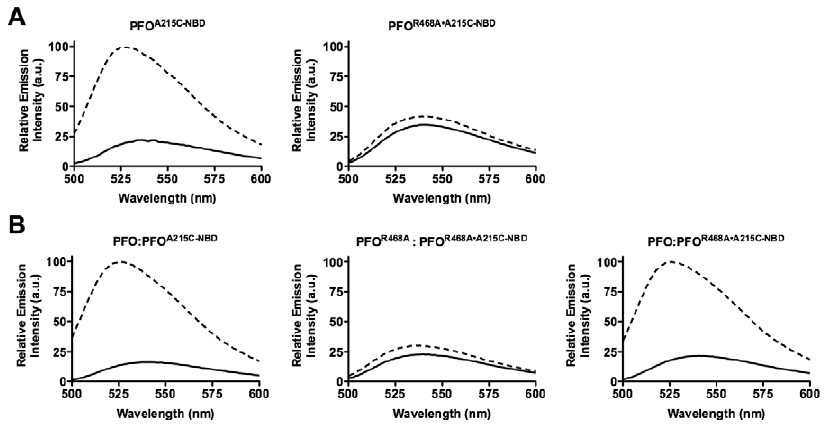
Figure 6. TMH insertion in PFO and PFO R468A . A cysteine was substituted for Ala-215 in PFO and PFO R468A , which is located in TMH1.The sidechain of Ala-215 is in an aqueous environment in the soluble monomer, but enters the membrane upon formation of the membrane spanning b - barrel [27]. Therefore an NBD probe positioned at this site undergoes a polar to nonpolar transition that is detected by an increase in the fluorescence emission of the probe.(A) Each NBD-labeled derivative was incubated in the presence (dashed line) and absence (solid line) of human erythrocyte ghost membranes. (B) Unlabeled native PFO or PFO R468A were mixed in a 4:1 molar ratio with PFO A215C-NBD and PFO R468A N A215C-NBD derivatives. The fluorescence emission for all experiments wasrelative to the maximum emission change observed for NBD-labeled PFO. The fluorescence emission intensity of NBD was measured from 500–600 nm. The data are representative of 3 experiments. doi:10.1371/journal.ppat.1002787.g006 quenched, but if the dye is released from the liposome its fluorescence emission increases upon dilution as it is released from the liposome [39,40,41]. PFO exhibited a dose-dependent release